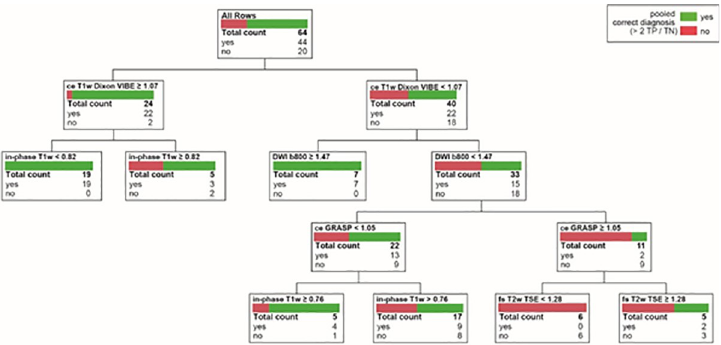
Fig 8. Decision tree analysis. This figure shows the decision tree analysis based on the tumor-to-background ratio thresholds of the employed sequences.